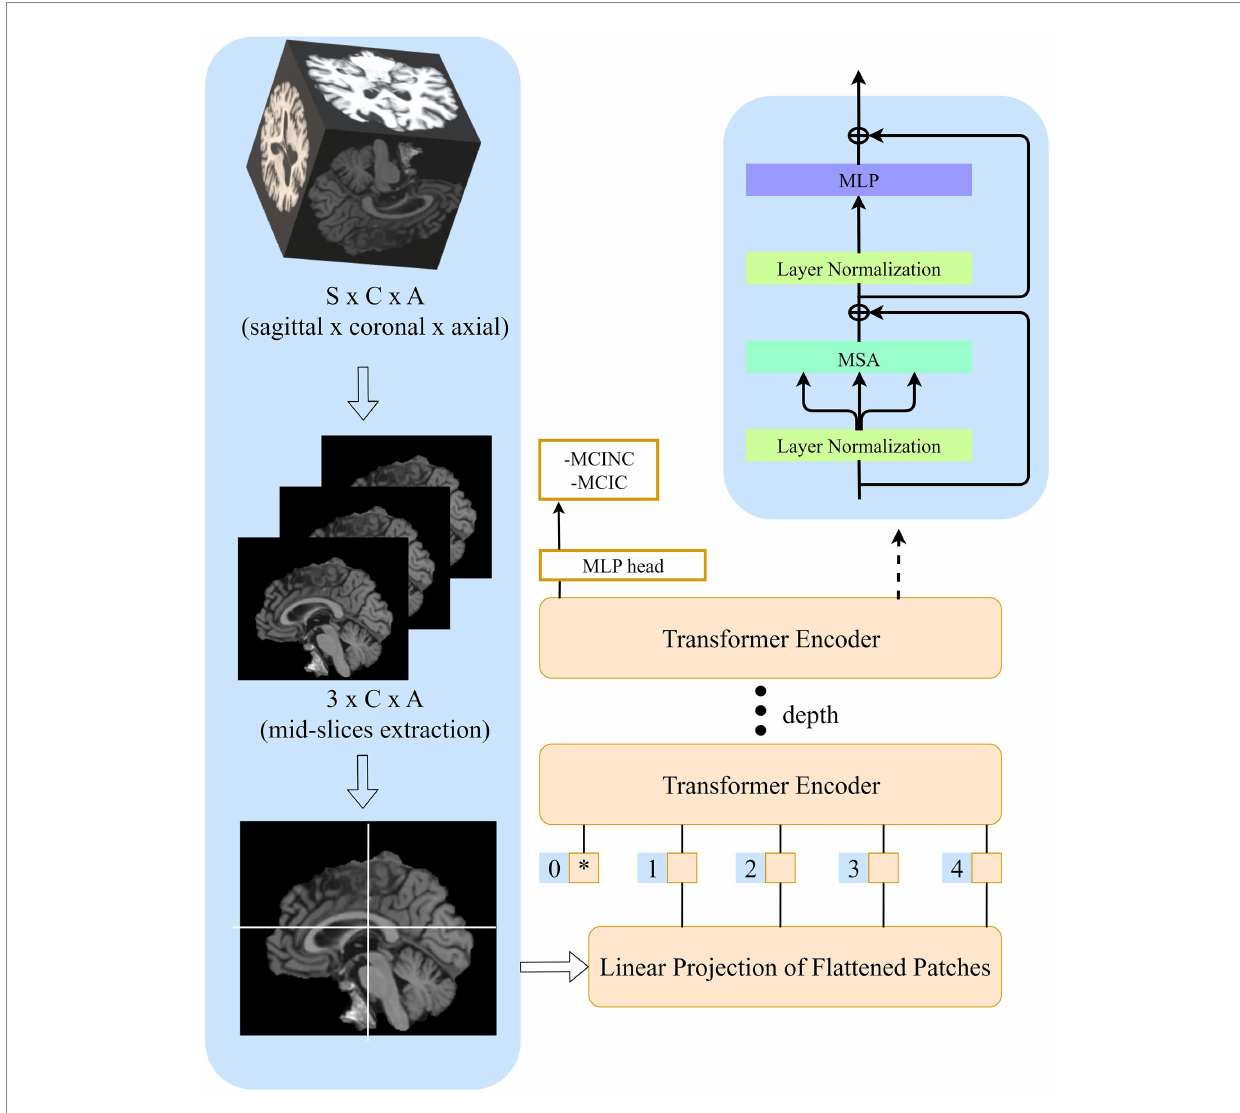
FIGURE 4 Overview of sMRI-based vision transformers model in prediction of MCI-to-AD